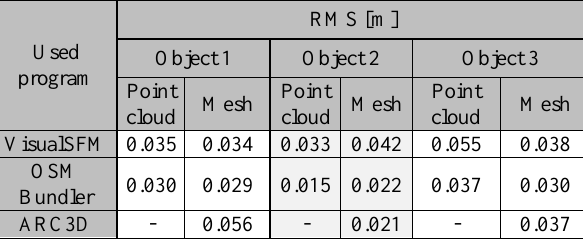
Table 1. RMS error calculated between thereference and on point cloud/3D model measurements.